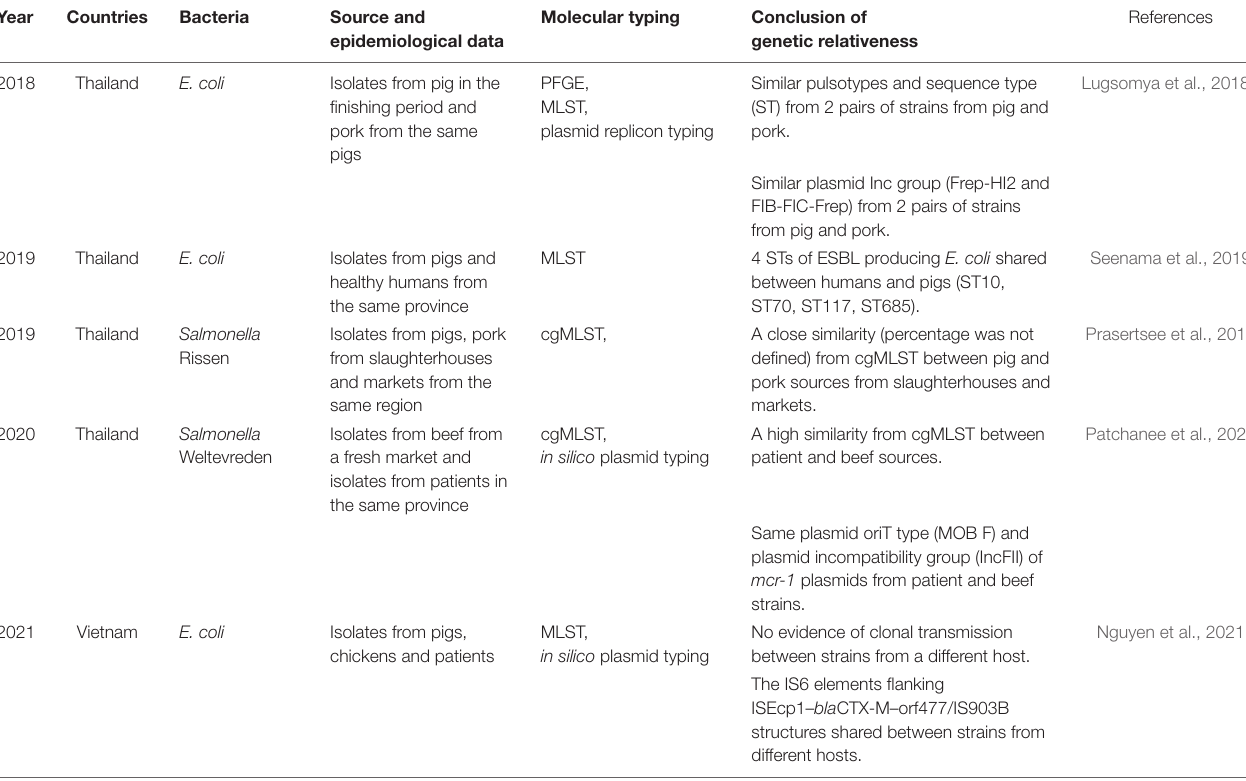
TABLE 2 | Lists of clonal relationships of AMR strains from South East Asia Countries in the One Health